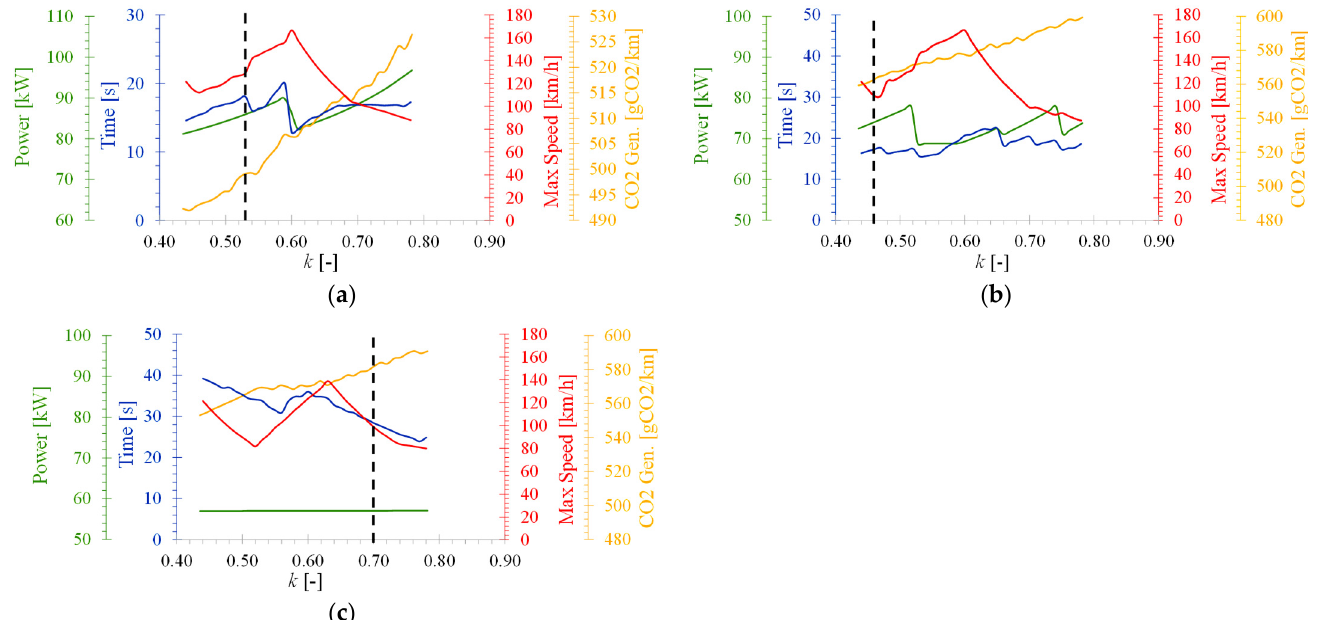
Figure 9. Effect of varying the ratio between gears ( 𝑘) on the vehicle performance metrics for ( a ) low SFC, ( b ) typical SFC, and ( c ) high SFC scenarios for the case of 50 km autonomy. Note: Skipped lines represent the best k value obtained in each scenario.